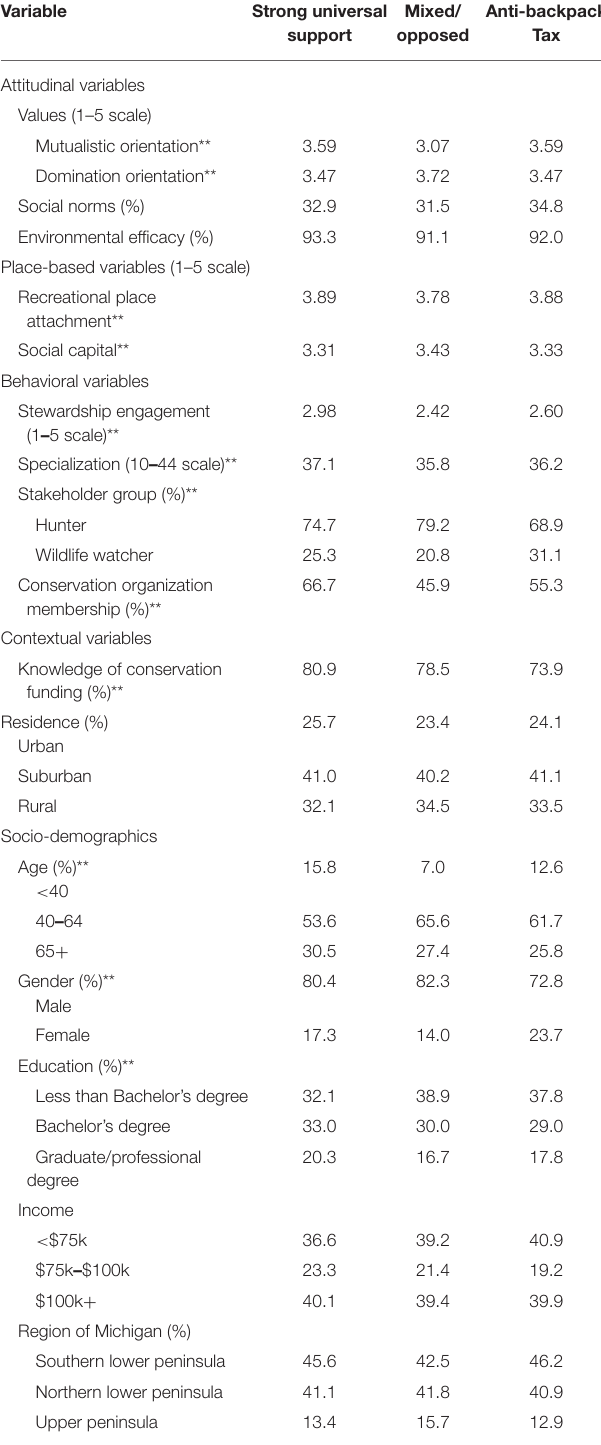
TABLE 3 | Characteristics of each respondent cluster (Mean value for continuous, % for categorical